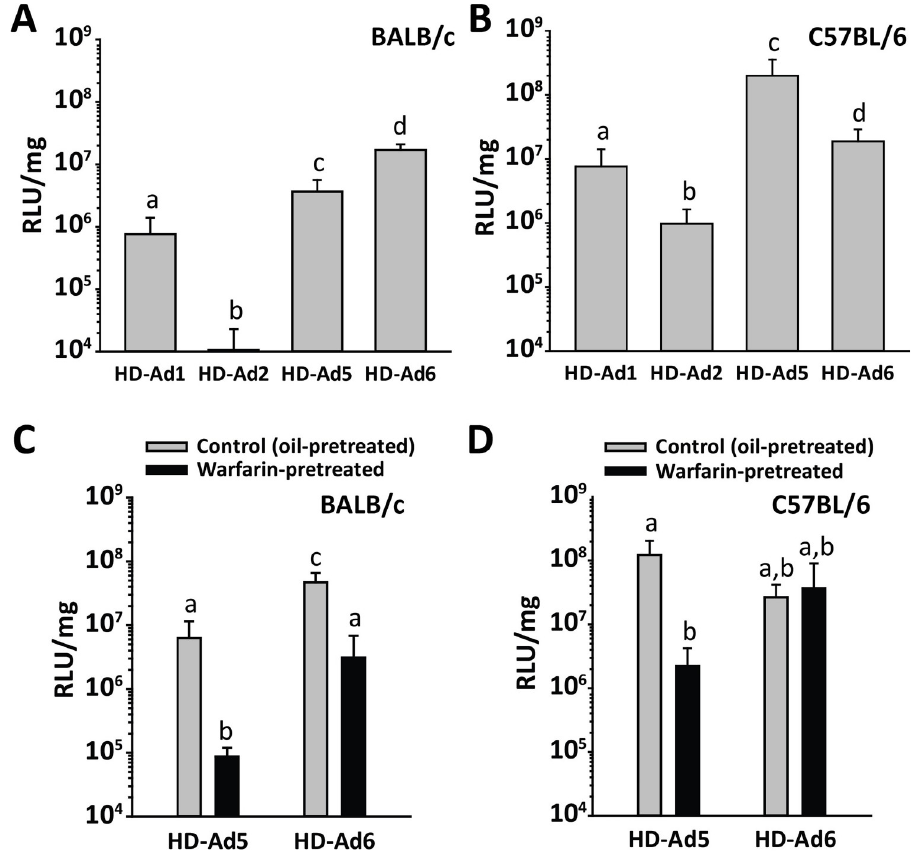
Fig 2. Effect of mouse strain and coagulation factors on liver transduction by species C Ad vectors. Mice were injected IV with luciferase-expressing HD-Ad vectors at a dose of 4x10 11 vp/kg. Mice were euthanized 48 h later, and liver luciferase activity was measured. Liver luciferase activity is shown in (A) BALB/c mice and (B) C57BL/6 mice. (C) BALB/c mice or (D) C57BL/6 mice were pre-treated with warfarin to deplete coagulation factors, then injected with HD-Ad5 or HD-Ad6 vectors and evaluated for liver luciferase activity. Control mice were pre-treated with vehicle (oil) before injection with vectors. n = 4–7 mice per group, mean ± SD. Statistical comparisons were performed using analysis of variance (ANOVA) and the Holm-Sidak post hoc test. Groups that do not share the same letter are significantly different from each other ( P � 0.05).